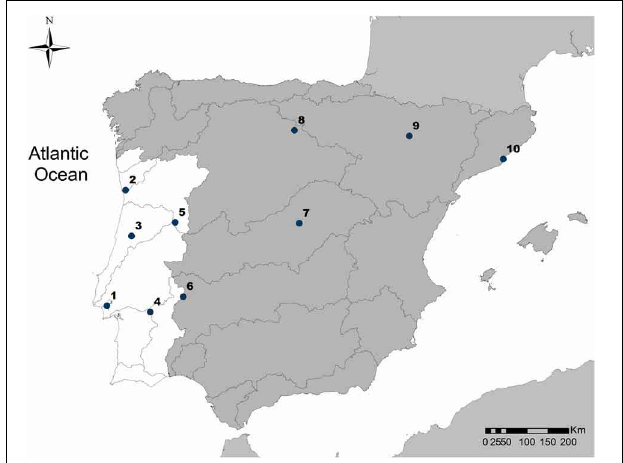
FIGURE 1 | Location of the available stations. 1- Lisbon, 2- Porto, 3- Coimbra, 4- Évora, 5- Guarda, 6- Badajoz, 7- Madrid, 8- Burgos, 9- Huesca, and 10-